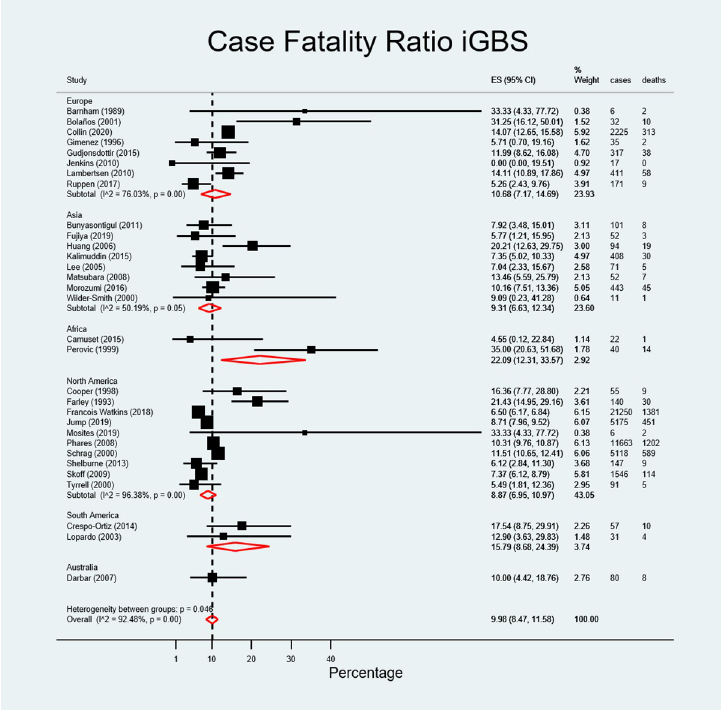
Fig 4. Pooled estimated case fatality ratio of invasive group B streptococcal infection by region.